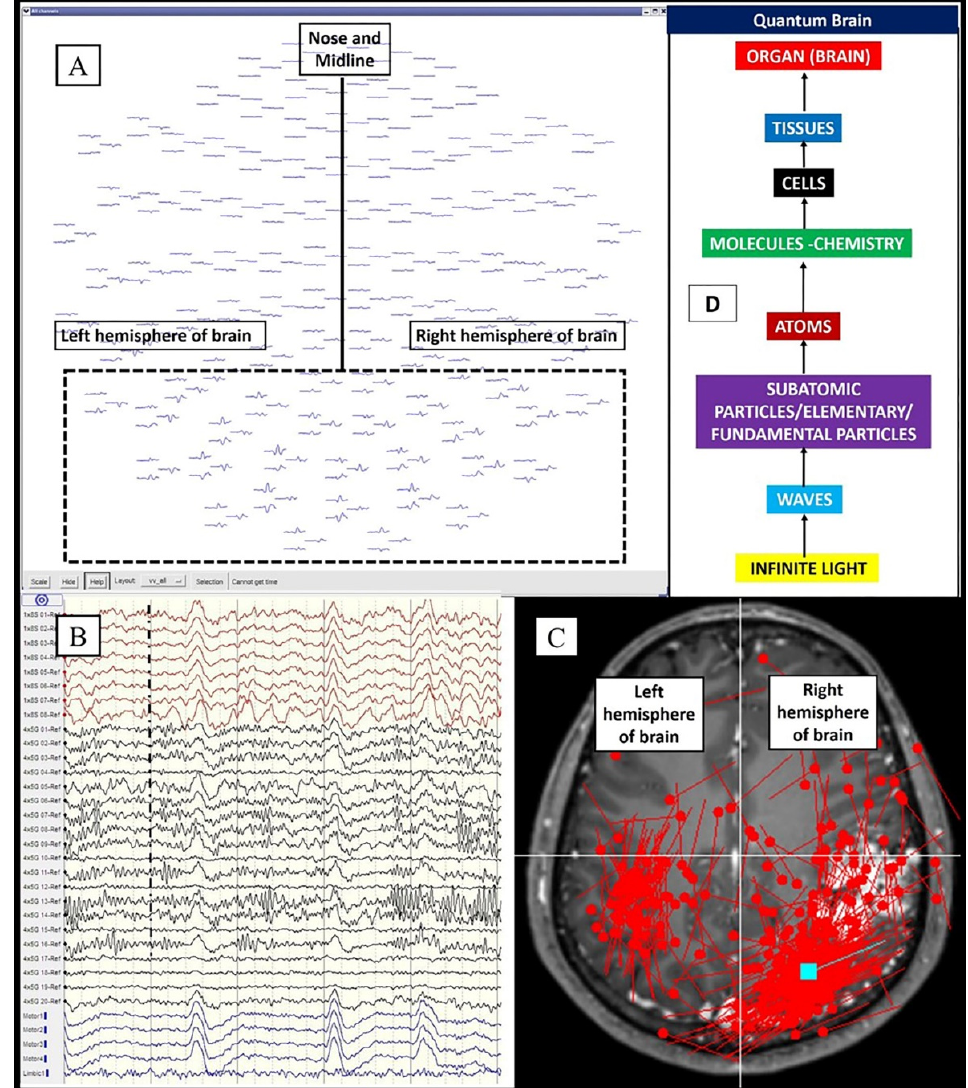
Figure 5. Quantum principles inside the brain. ( A ) The visually evoked magnetic field obtained through magnetoencephalography (MEG) as an example of an entangled electromagnetic field that has bihemispheric inversed potential responses. ( B ) Brainwaves obtained via ECoG (uppermost and middle, i.e., red and black waves) and EEG (bottom, blue waves): the normal areas of the brain (red and blue) have coherence or harmony waves, whilst the black (abnormal) areas exhibit decoherence (chaos/disharmony) in a psychotic epilepsy patient. ( C ) Despite the presence of a lesion in only the right hemisphere of the brain, epileptic spikes detected using MEG were noted in both hemispheres (may also be a sign of entanglement and/or tunneling; note that the slower detectable time response in the opposite brain hemisphere may be due to the measurement instrument used). ( D ) The brain and its anatomical hierarchy; the quantum part remains unexplored. Table 1. General features of the brain electromagnetic field (EF or EMF) and brain quantum field (QF) or brain quantum– light field (QLF).